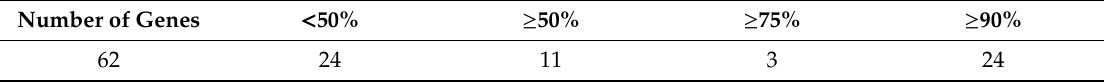
Table 1. The di ff erences of interactome profiles for proteoforms encoded by the same Table 1. The differences of interactome profiles for proteoforms encoded by the same gene.